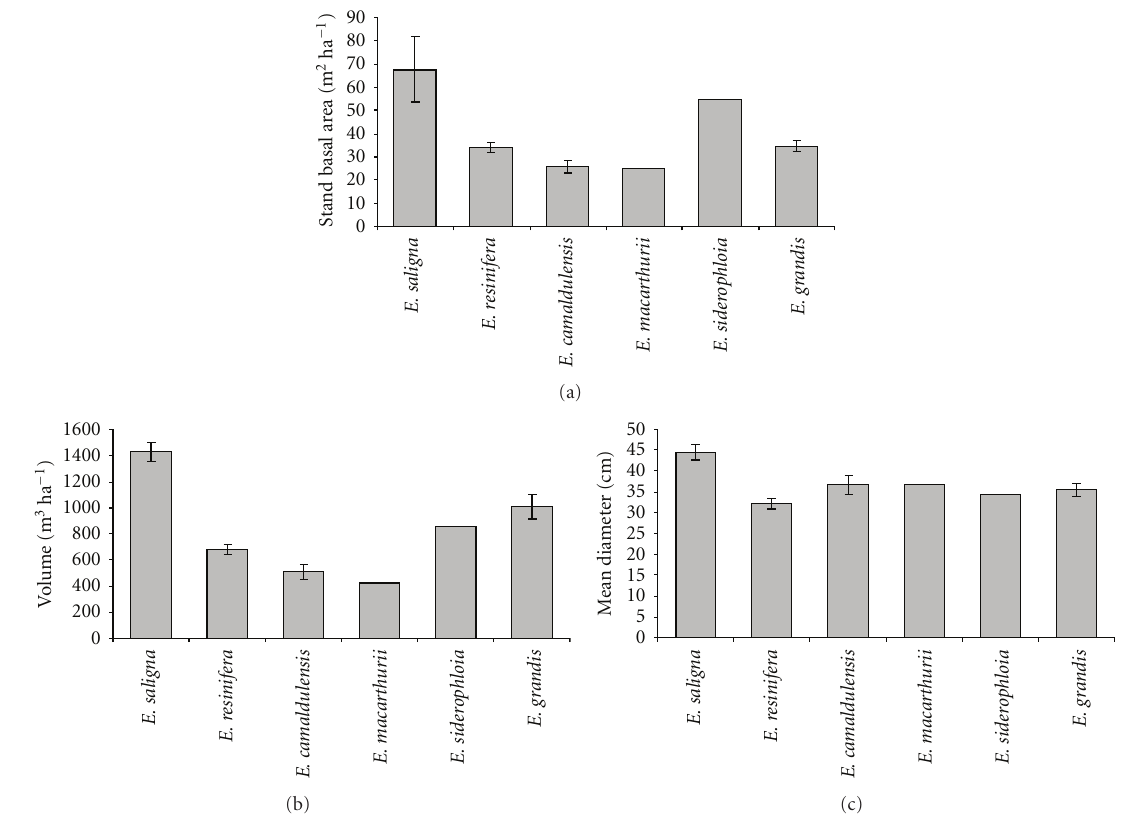
Figure 4: Stand volume, stand basal area, and mean diameter of six Eucalyptus at 43 years of age in the Tchianga experiment. The vertical lines indicate the standard error of